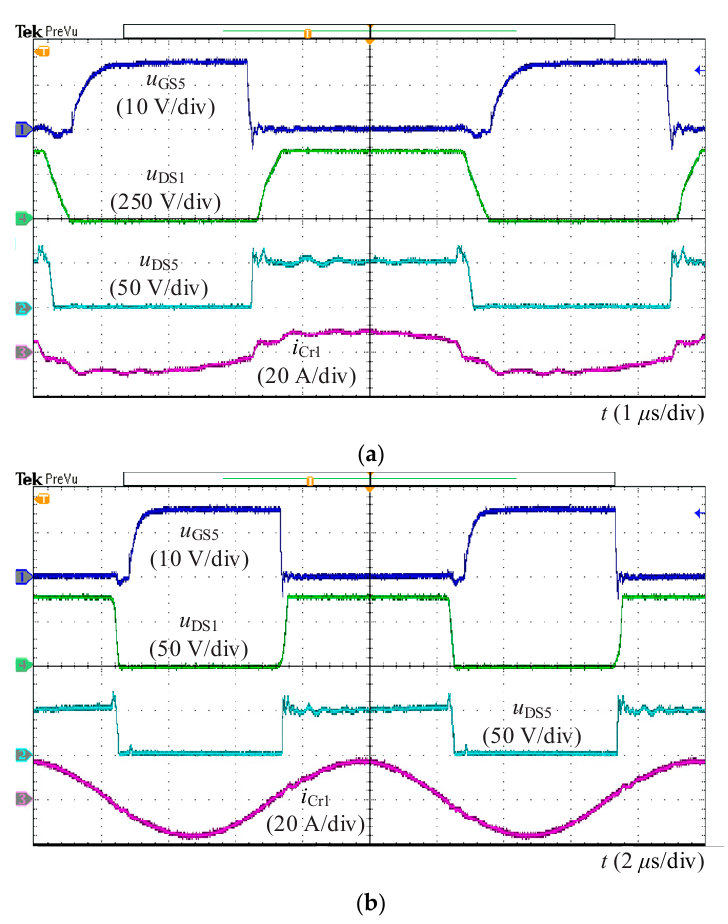
Figure 16. Experimental results in backward mode: ( a ) 160 kHz, 2.5 kW; ( b ) 100 kHz, 5 kW.